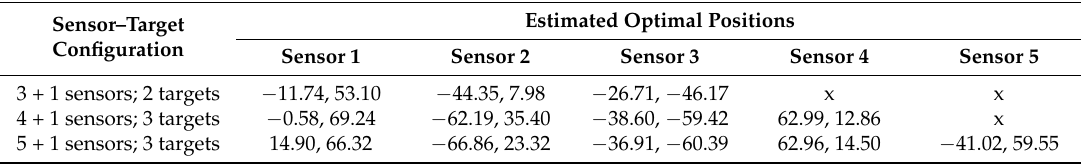
Figure 7. ( a ) 2D contour plot of the evaluation function (4 + 1 sensors, three targets); ( b ) 3D plot of the evaluation function (4 + 1 sensors, three targets).